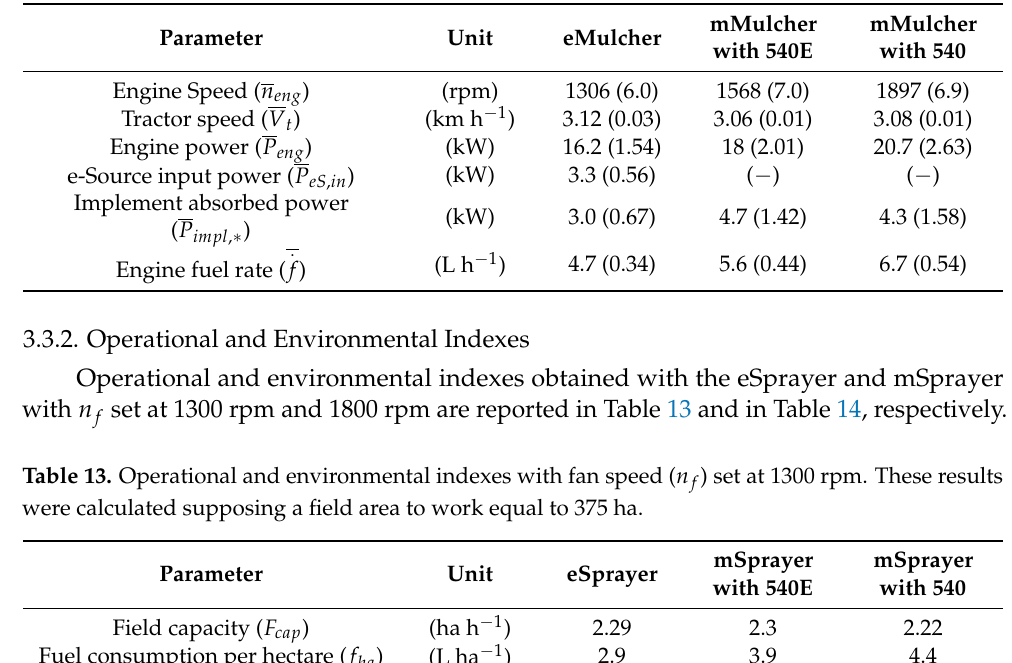
Table 12. Performance parameters obtained with the mulchers on SimVin. In the brackets, the standard deviation of each parameter is reported.